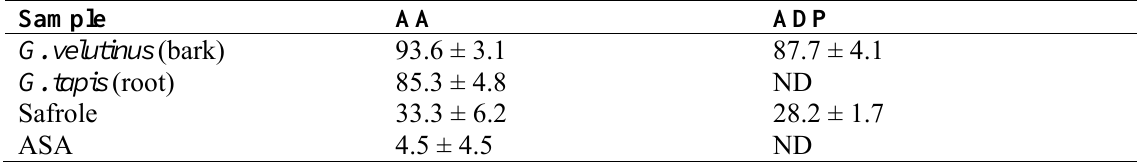
Table 4. IC values (µg/mL) of the bark oil of Goniothalamus velutinus and the root oil of 50 G. tapis , safrole and aspirin on platelet aggregation induced by AA (0.5 mM) and ADP (10 µM) in human whole